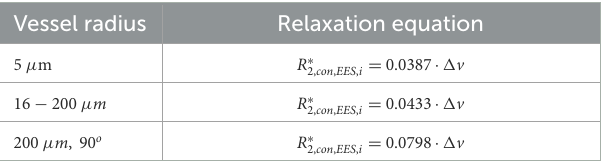
TABLE 1 Coefficients for extravascular relaxation rates in various vessel radii.